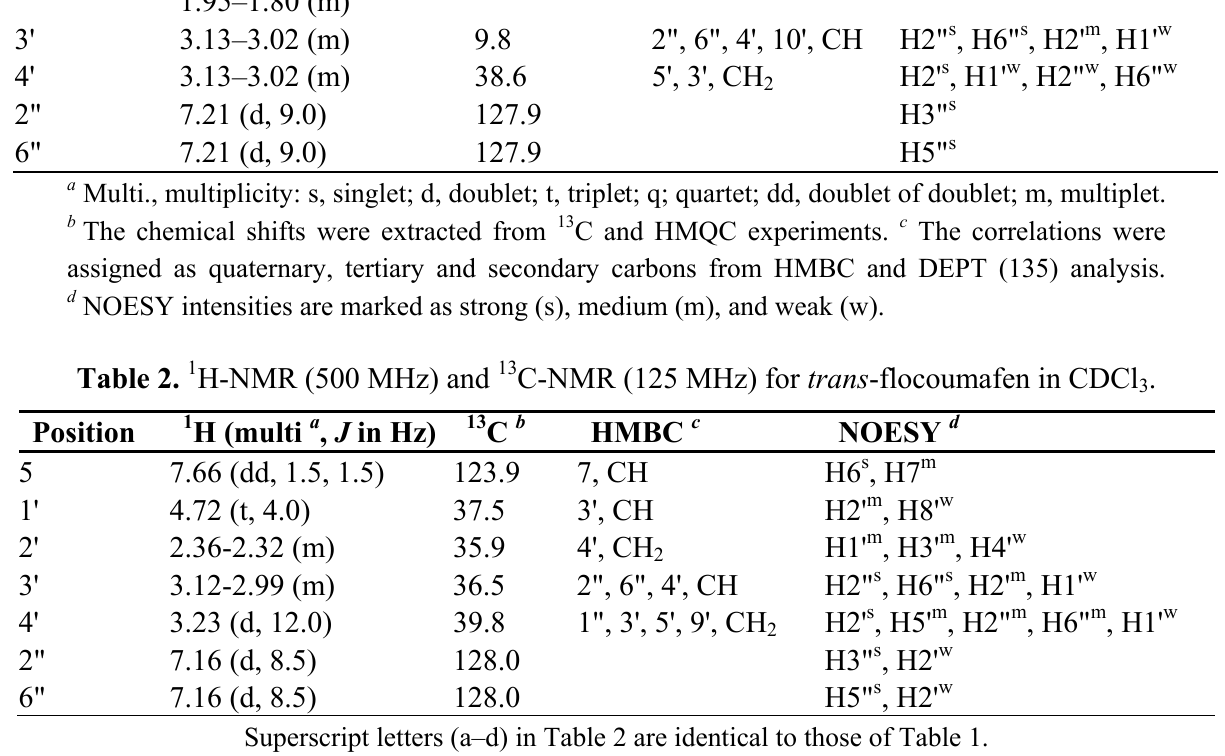
Table 1. 1 H-NMR (500 MHz) and 13 C-NMR (125 MHz) for cis -flocoumafen in CDCl